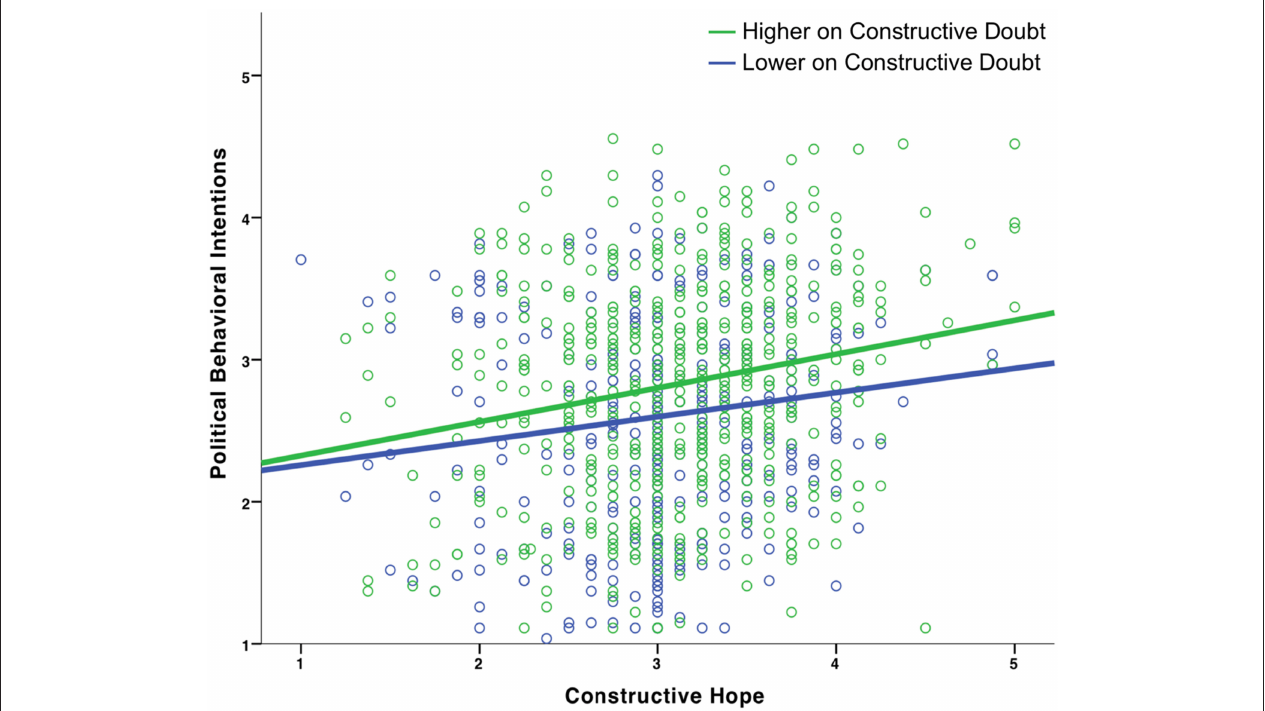
FIGURE 1 | Interaction effects of constructive hope and doubt on political behavioral intentions. Higher constructive doubt (green) refers to respondents scoring a four or more on the doubt measure ( n = 535) and lower constructive doubt (blue) refers to those scoring a three or below ( n =